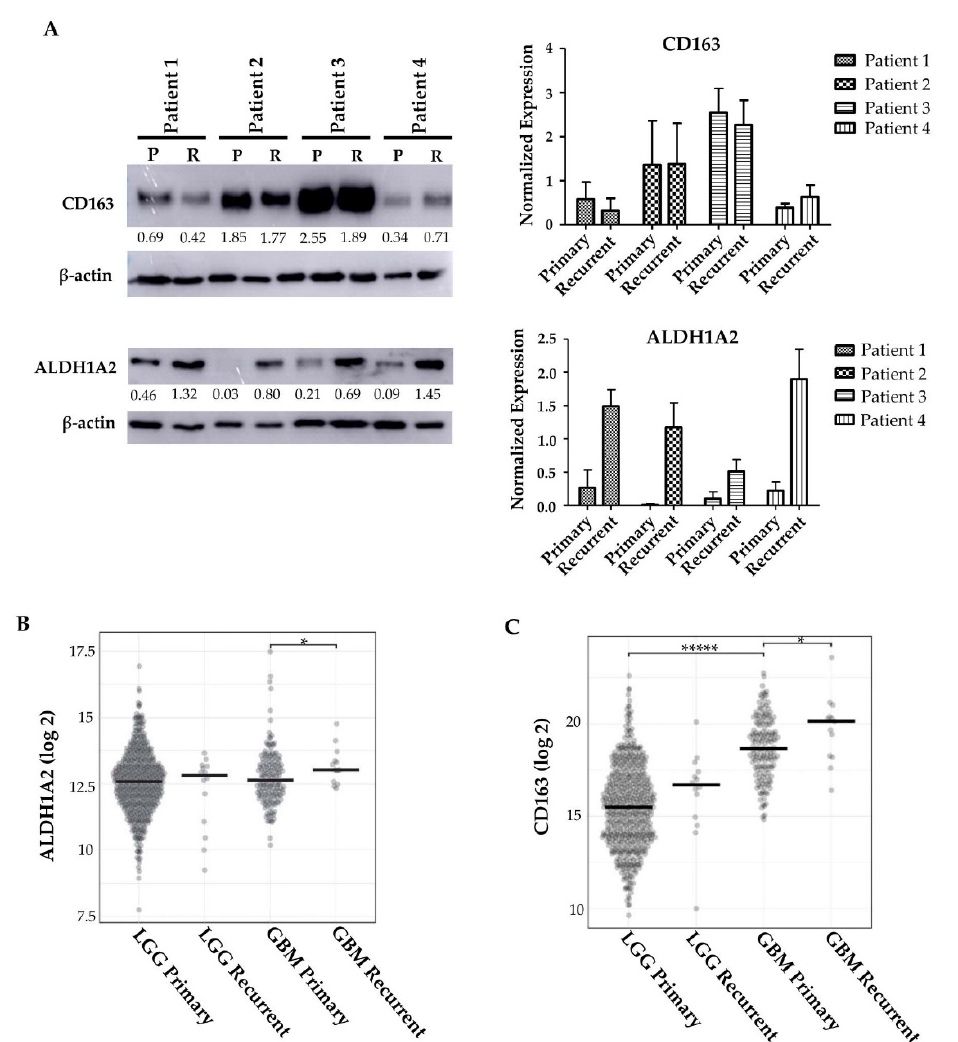
Figure 5. ALDH1A2 expression changes upon tumor recurrence. ( A ) ALDH1A2 and CD163 + expression in the recurrent tumors of 4 matched patient tumors (representative of at least 2 blots). ( B ) TCGA analysis of ALDH1A2 gene expression in LGG and GBM primary and recurrent tumors. * indicates p = 0.048. ( C ) TCGA analysis of CD163 gene expression in LGG and GBM primary and recurrent tumors. ***** indicates p < 0.0001, * indicates p = 0.036.